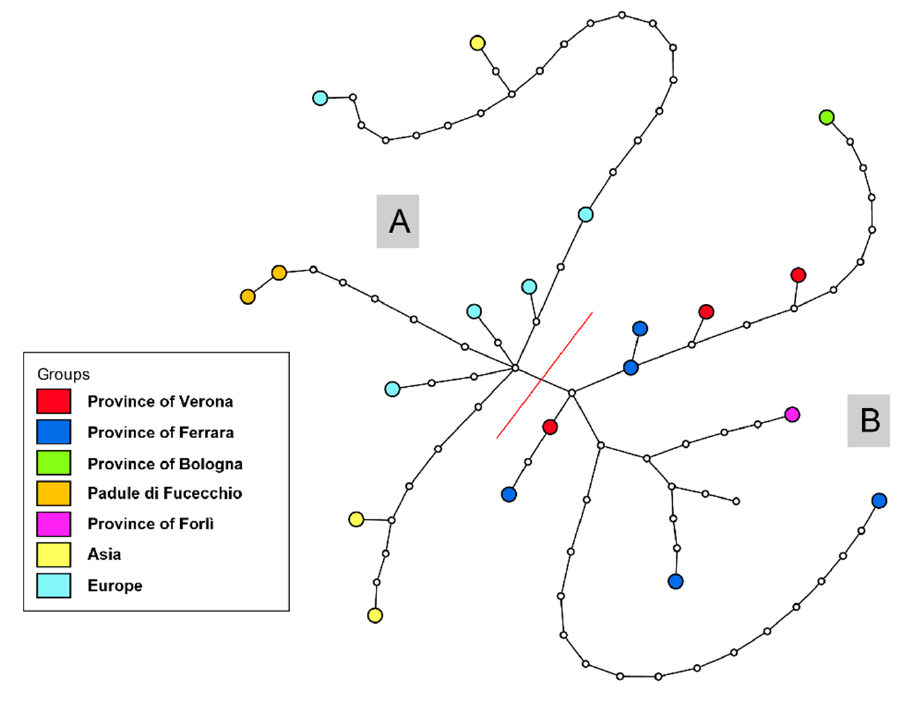
Figure 3. Median-Joining haplotype network topology obtained for the cytb data of Micromys minutus in Italy, Europe, and Asia. Haplotypes are depicted according to sampling sites. Uncoloured circles represent mutation steps. The red line separates ( A ) Italian haplotypes from ( B ) Asian, European, and two Italian (Padule di Fucecchio) haplotypes (average: 12.31 nucleotide differences among populations).